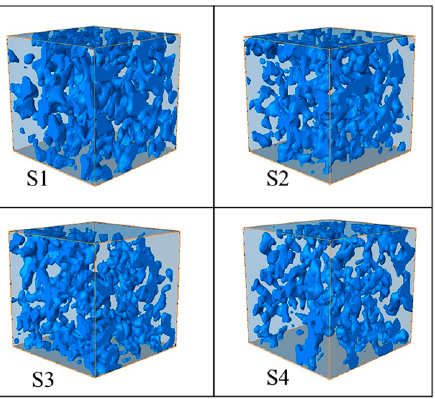
Figure 6. Evolution of pore structure in bed slurry: The pore structures of samples S1, S2, S3 and S4 are shown in Figure. Figure 7 indicates that the porosity of S1 was the maximum (46.48%) in the event of no shear action. The porosity presented a declining linear trend as the shear time passed. After the shear action was completed, the porosity was 37.46%, indicating a decline of 19.21%. This finding indicated that the unclassified tailing bed thickening effect could be enhanced by the shear action. The porosity of S1 to S2 showed minor changes. As a result of the stirring of the rake rack, the floc structure experienced recombination-fracture- recombination, the sealed holes inside the flocs were opened and the unconnected pores were rearranged before the sealing water was drained, thereby creating conditions for the subsequent drainage.